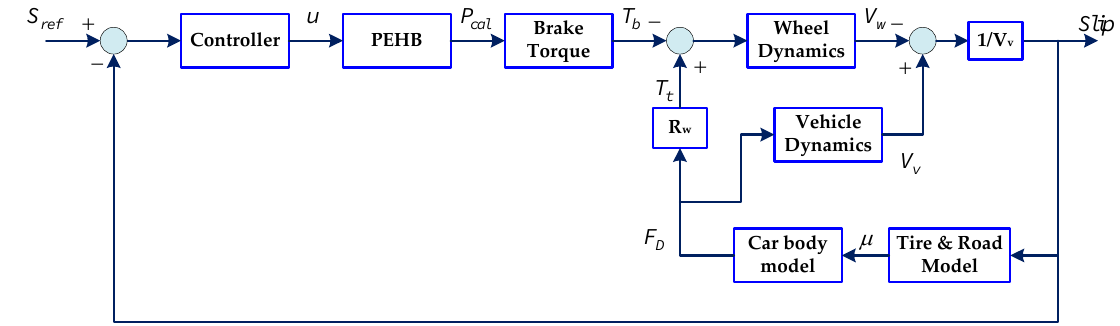
Figure 11. Block diagram of the anti-lock braking control system.